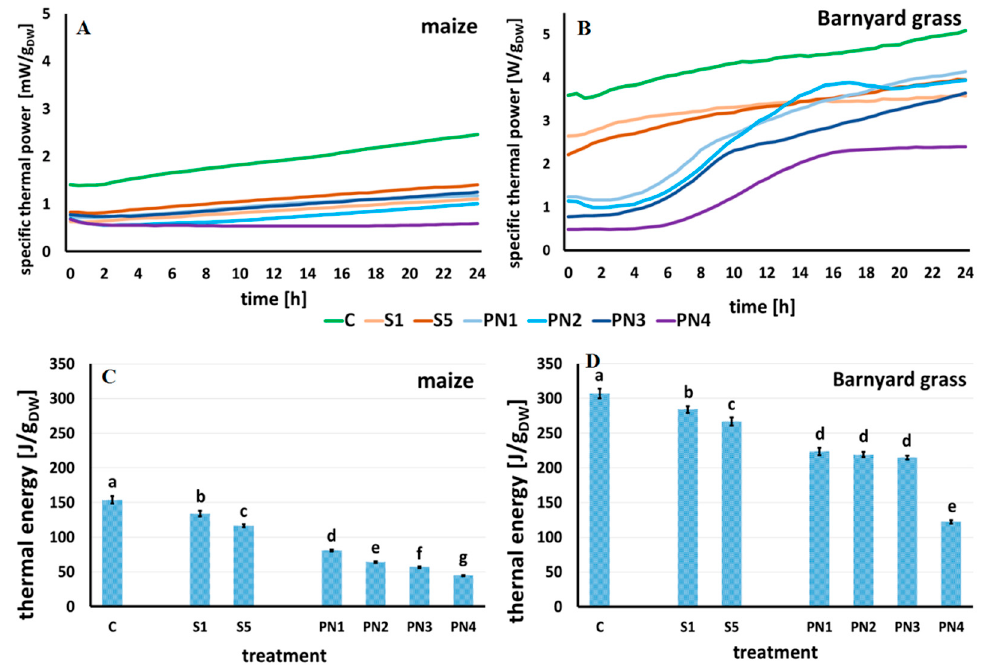
Figure 5. The specific thermal power curves of the maize ( A ) and barnyard grass ( B ) seedlings growing on the surfactants (S1 light orange line and S5 dark orange line), nanoemulsions with peppermint oil (PN1 light blue line, PN2 cyan line, PN3 dark blue line, PN4 violet line) and water (C green line). The total heat emitted by maize ( C ) and barnyard grass ( D ) seedlings growing on the surfactants S1 (1% v / v ) and S5 (10% v / v ), nanoemulsions with peppermint oil PN1 (1% v / v ), PN2 (1.5% v / v ), PN3 (2% v / v ), PN4 (5% v / v ), and water (C). Mean values ± SD. The letters a–g indicate statistically significant differences. Values indicated by the same letters did not differ significantly